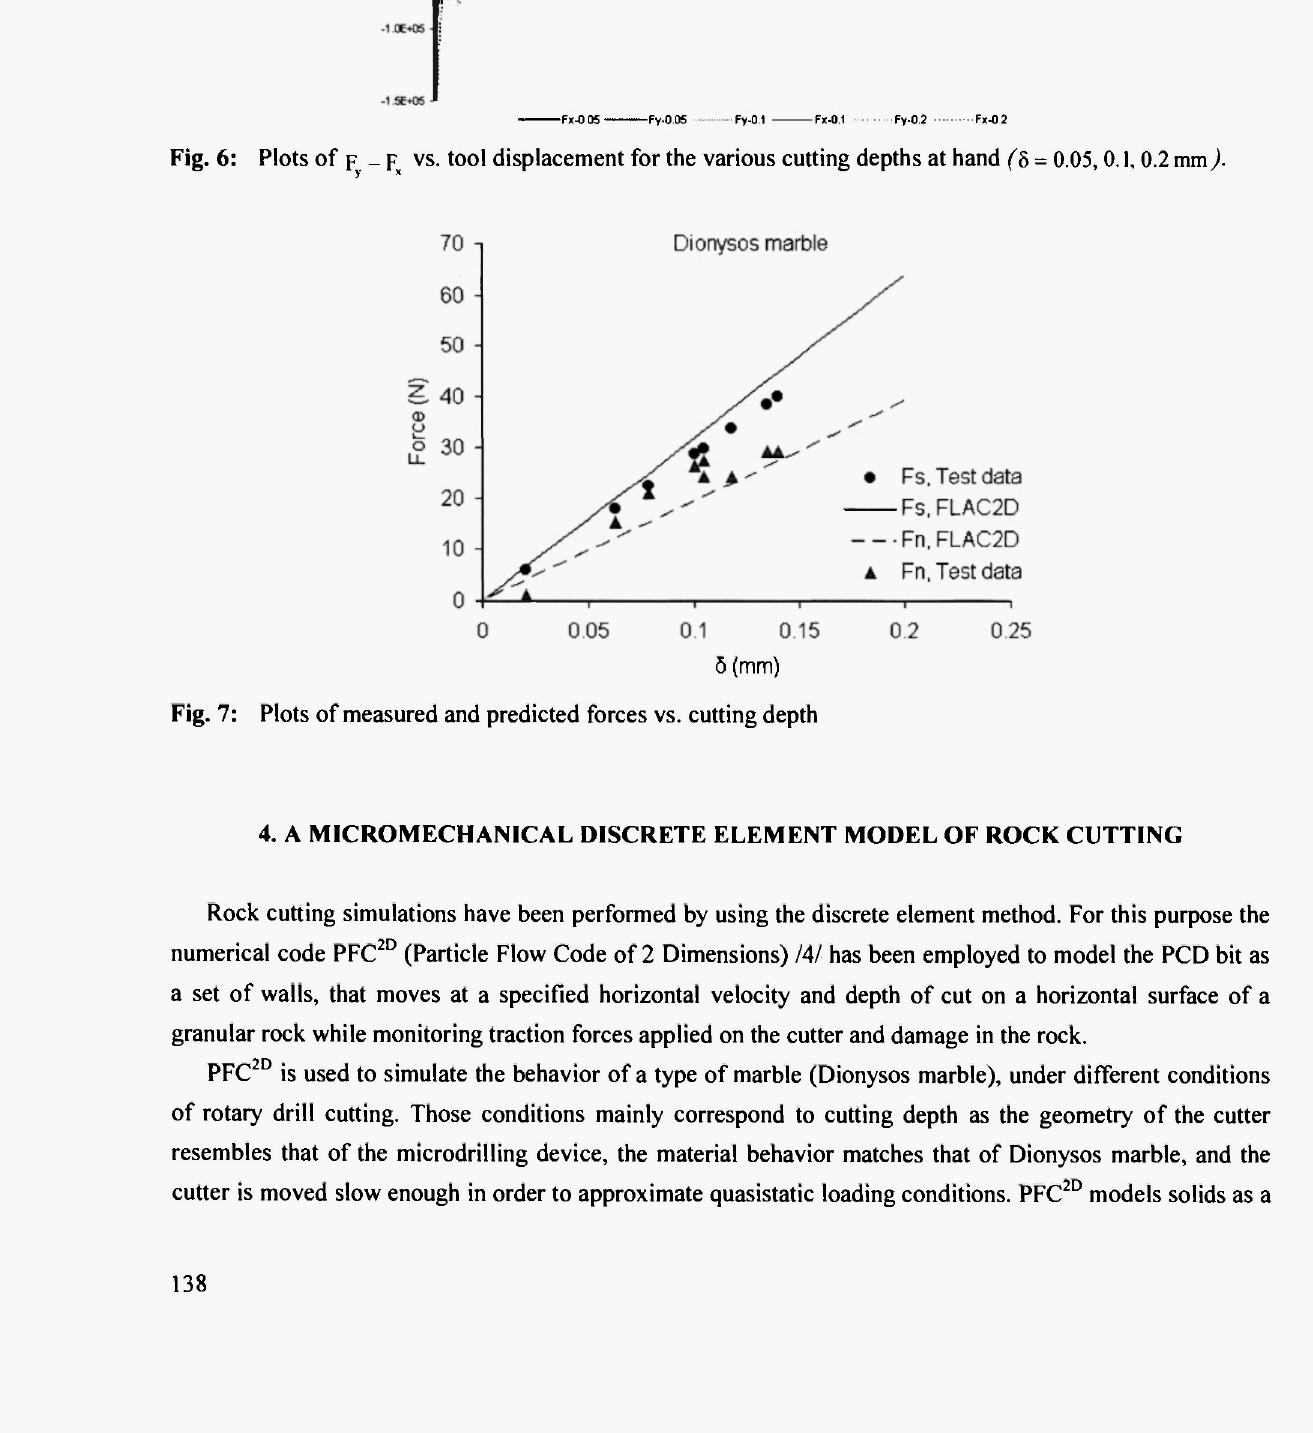
Fig. 6: Plots of f y - F x vs. tool displacement for the various cutting depths at hand (δ = 0.05,0.1,0.2 mm).